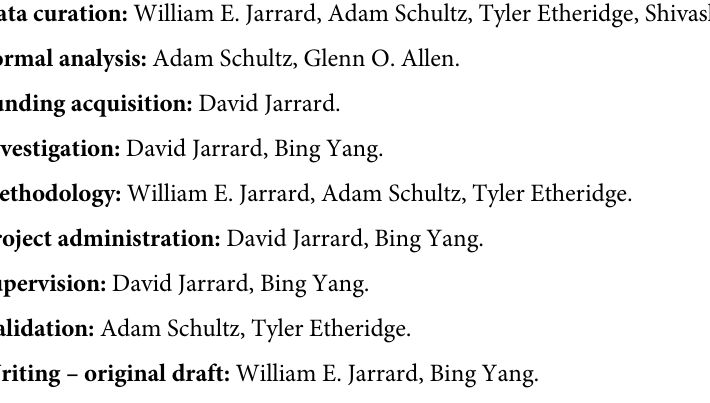
S1 Table. Clinical and pathologic characteristics of prostate biopsies. S2 Table. The list of the probes showed significantly altered methylation in the urine sam- ples associated with PC. S3 Table. Methylation levels for all type of specimens. Methylation is shown as percentage Mean (SEM), t-test, p-value. Methylation for Prostatectomy tissues was analyzed by one-way Anova, p-value is not shown here. S4 Table. Methylation levels of samples containing inflammation and no inflammation in both urine and biopsy samples from the patients without PC. Methylation is shown as % Mean (SEM), t-test, p-value. � n is the slide number for biopsy specimens. Samples containing severe inflammation were excluded from